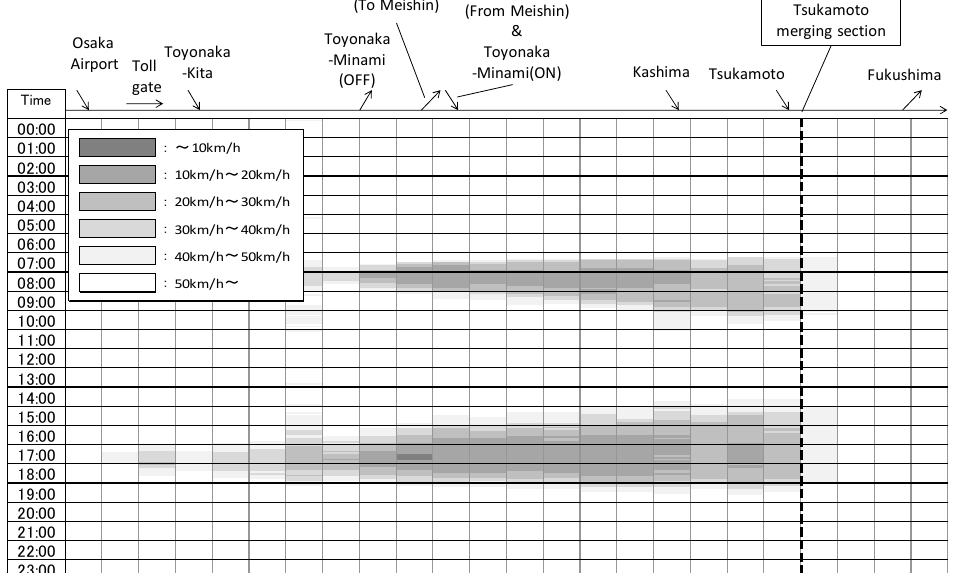
Figure 3. Velocity contour map (November in 2015).